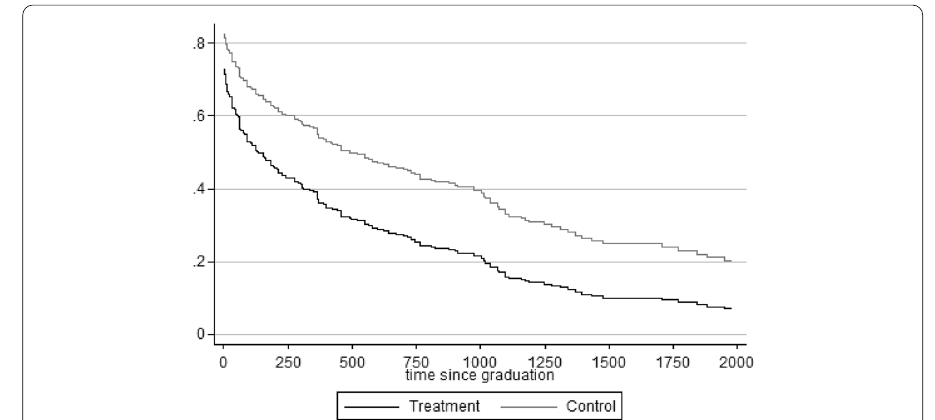
Fig. 1 The share of graduates that stick to the training facility in dependence on time since graduation and treatment status (in percent). The graph displays the share of graduates that has not left the training facility in dependence on days since graduation and treatment status, yet. Survival rates are calculated based on Model 3 of Table 2 with conditioning on variables summarized in Table 1. An individual is assigned to the treatment group if he or she began the apprenticeship training at the point in time when the federal state, where the individual resides, have already introduced the levy scheme. Source: Sample of Integrated Labour Market Biographies 1975-2017 (SIAB 7517v1); Regional Database of the Federal Statistical Office and the Federal Employment Agency, own